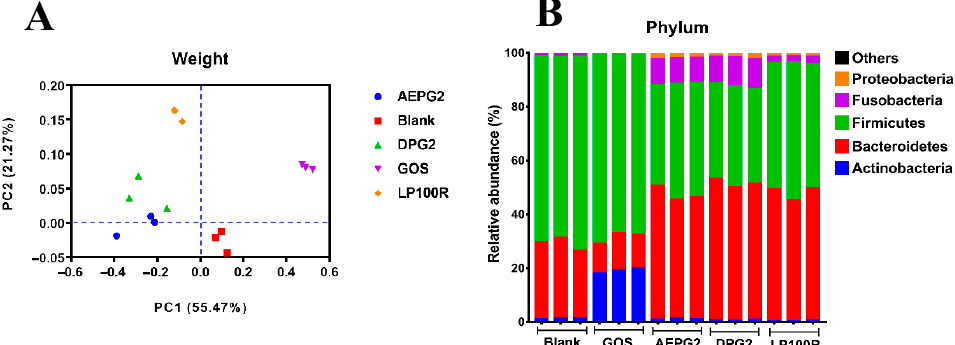
Figure 6. ( A ) Principal coordinates analysis of gut microbiota; ( B ) gut microbial composition at phylum level.